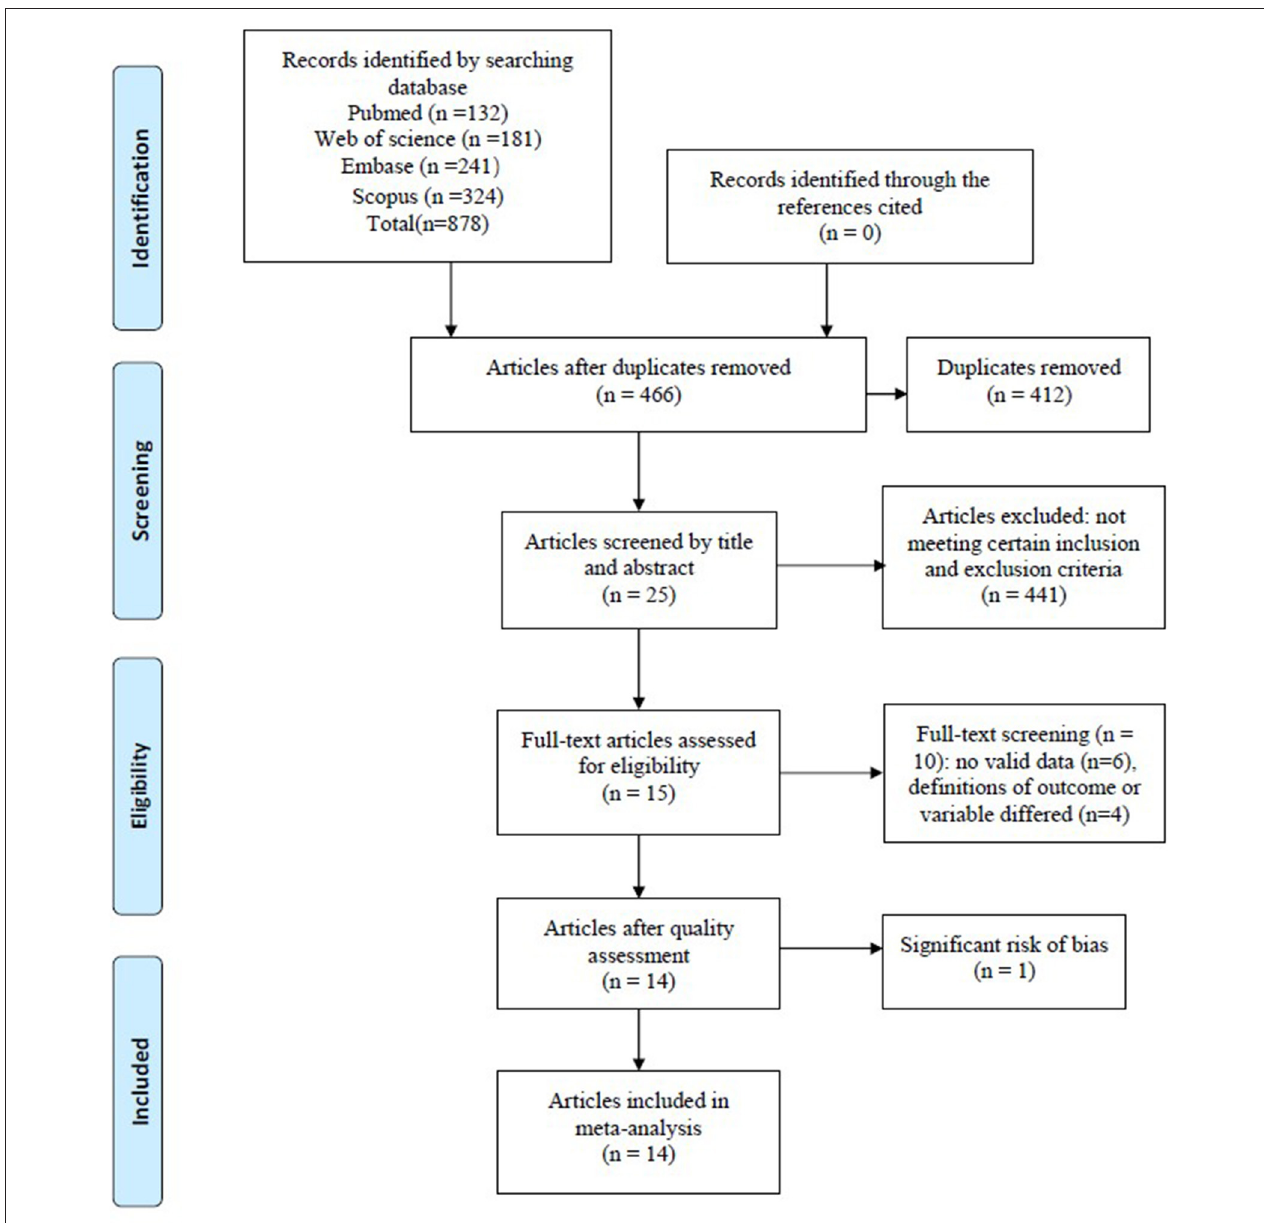
FIGURE 1 | Flowchart of document